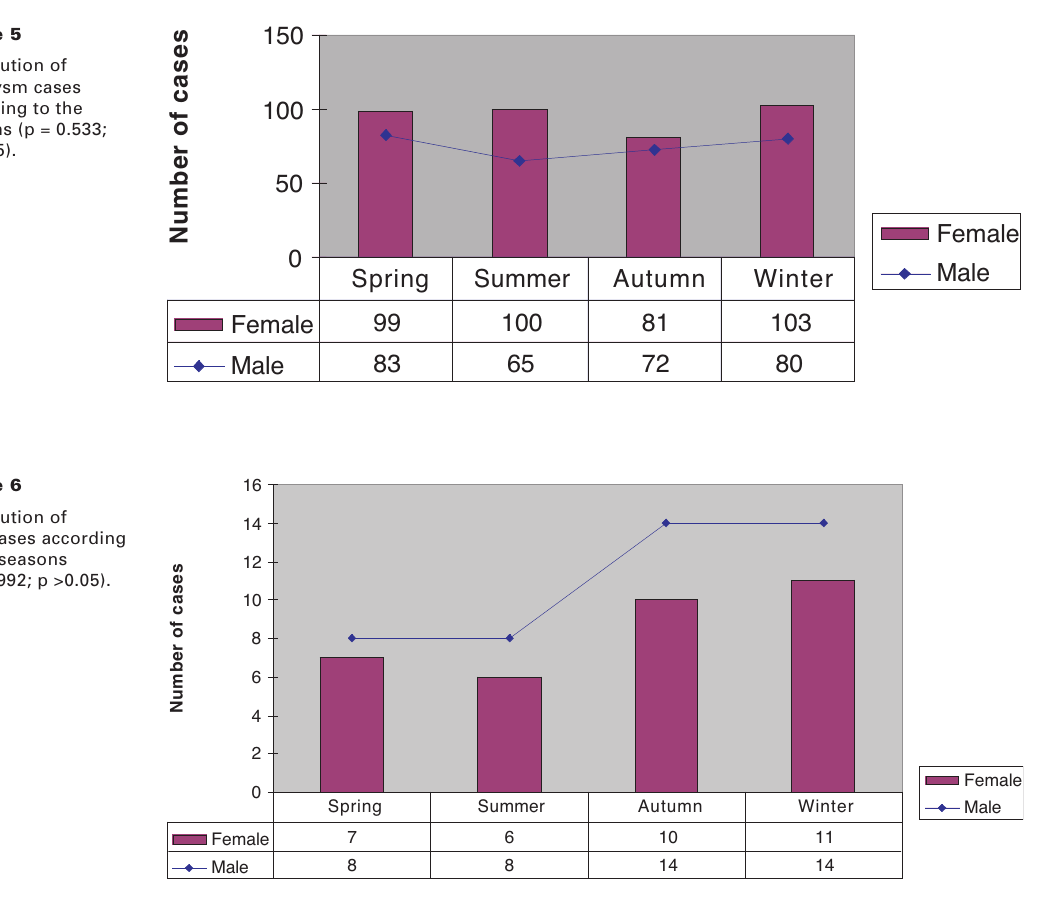
Seasonal influence in spontaneous bleeding of intracranial aneurysms